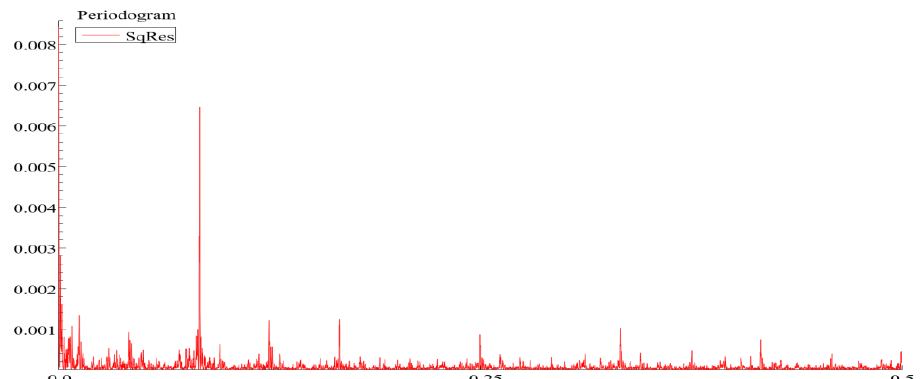
Figure 4. Periodogram of the squared residuals of the k -factor GARMA model. Table 4. Results of GPH and LW tests in the conditional variance.